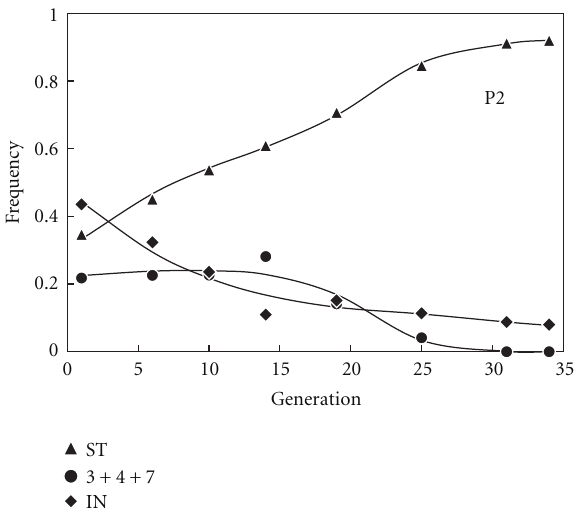
F 2: Observed frequencies and predicted trajectories of popu- lation P2 (same speci�cations as in legend of Figure